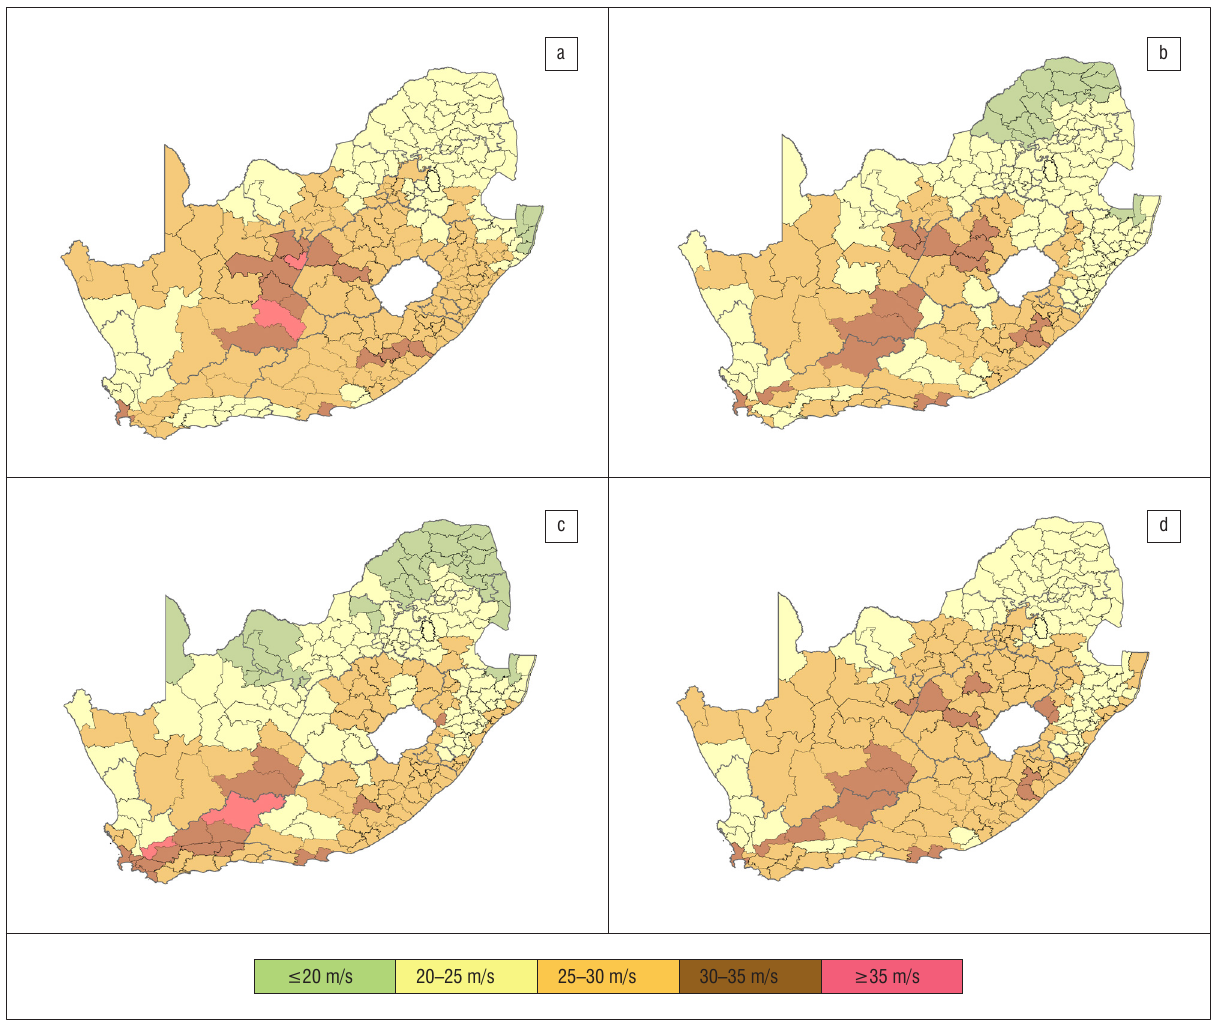
Figure 5: Magnitude, defined as the highest wind gust in m/s to expect in 10 years, per season: (a) Summer (DJF), (b) autumn (MAM), (c) winter (JJA) and (d) spring